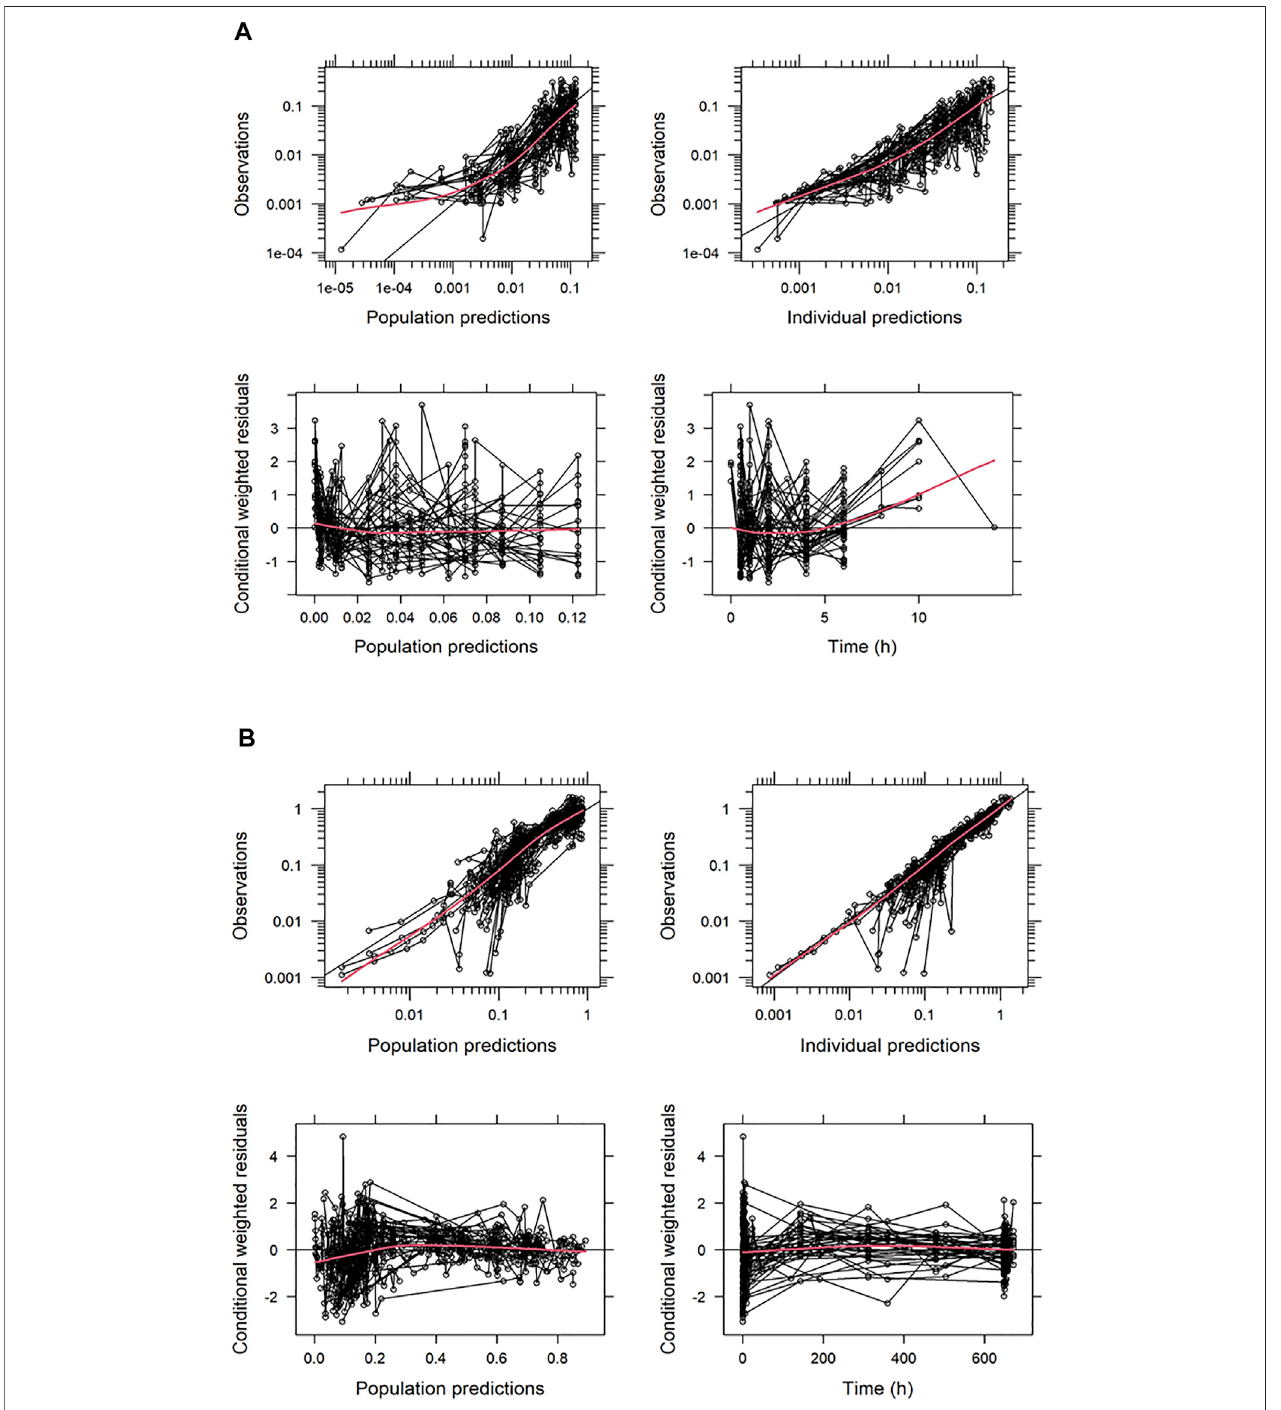
FIGURE 2 | Basic Goodness-of-Fit Plots for TQ-B3101 (A) and TQ-B3101M (B) . All the concentrations are provided in nmol/mL. The red solid lines indicate loess smoothing lines.